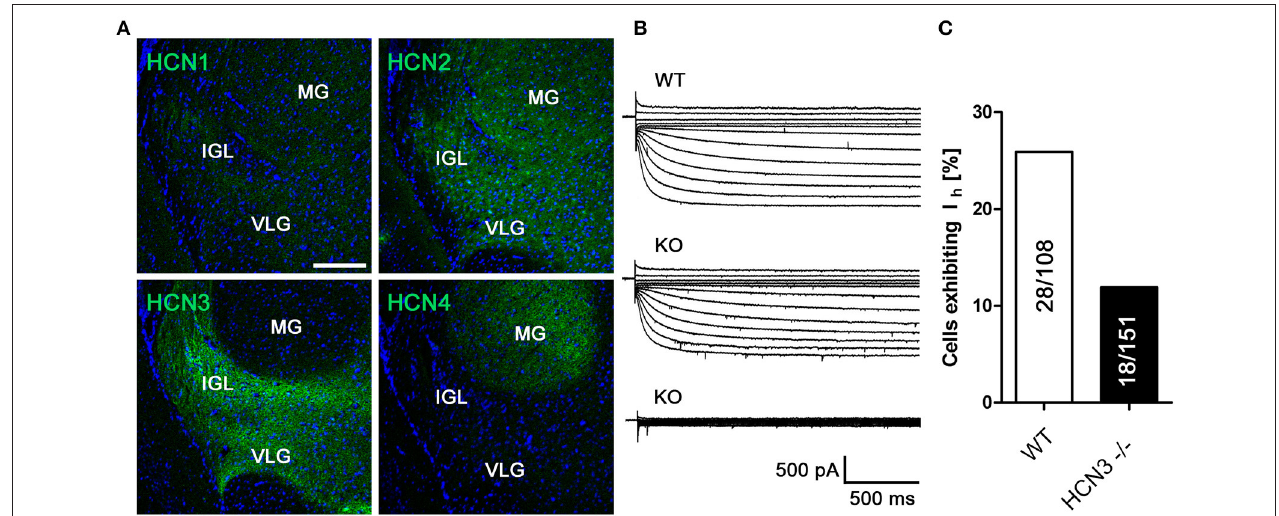
FIGURE 3 | HCN3 channels are expressed in the intergeniculate leaflet and contribute to I h . (A) Expression of HCN channel subtypes in the intergeniculate leaflet (IGL), medial geniculate nucleus (MG) and ventral geniculate nucleus (VLG); Scale bar, 200 µ m. (B) Family of current traces for I h recordings in acute slice preparations containing the IGL. Upper panel: recordings from WT preparations. In slices prepared from HCN3 − / − mice, two populations of cells were present, one containing I h (middle panel), which is most likely carried by HCN2, and one without I h (lower panel). (C) Number of tested IGL neurons exhibiting the I h current in relation to the number of tested cells given in